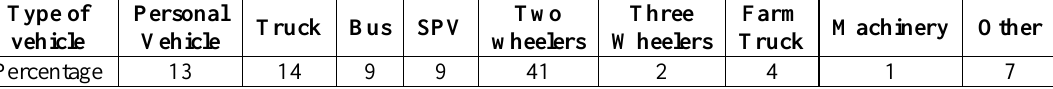
Figure 9: Trend of accident data 2010-11/2019. Source: [33]. Table 16: Cases with respect to Impacting vehicles by Types (1/2019~6/2019).